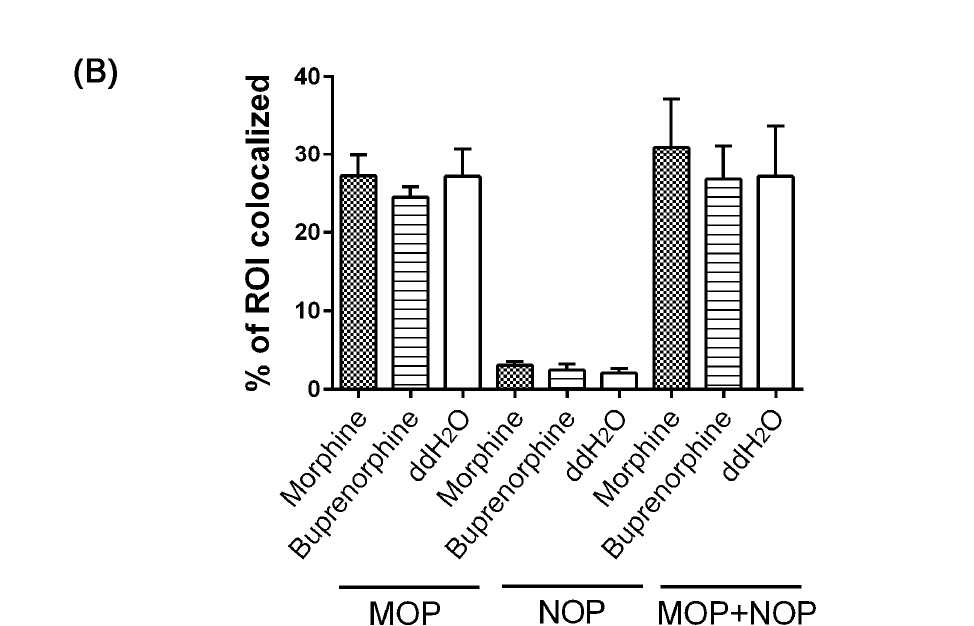
Figure 3. Representative confocal images ( A ) and colocalization rates of MOP and NOP on lipid rafts (red) ( B ) from HEK 293 cells stably expressing HA-tagged MOP (green) and/or myc-tagged NOP (magenta) after exposure to morphine (1 µ M) or buprenorphine (1 µ M) for 20 min at 4 ◦ C. The inset panels display higher magnification images highlighting the colocalization. Scale bars are equal to 10 µ m. Each bar represents the mean ± SE value of the percentage of ROI colocalization derived from five independent experiments with 4–6 individual cell images in each group.